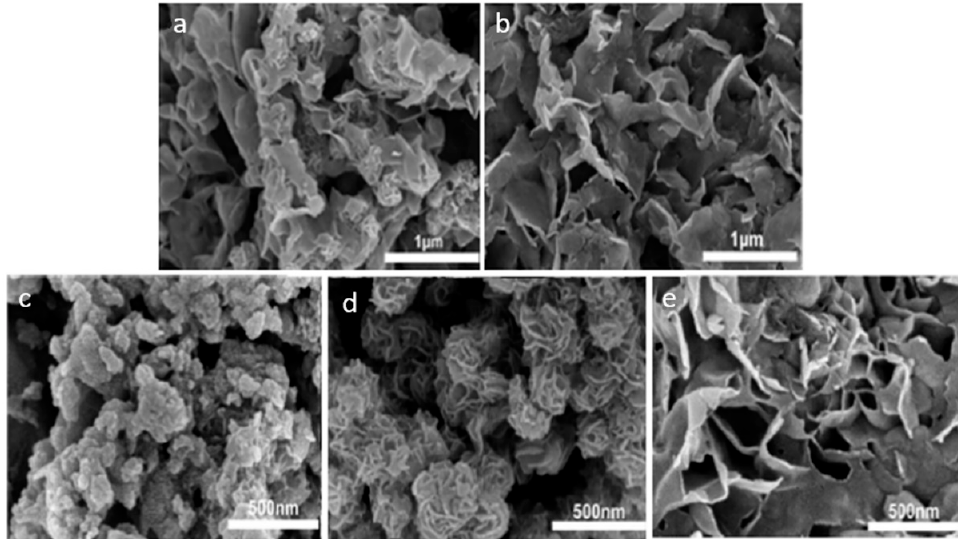
Figure 3. SEM images of MoS 2 composites synthesized via the hydrothermal method. ( a ) S/Mo molar ratio 1:1; ( b ) S/Mo molar ratio 4:1; ( c ) synthesis time: 25 h at 150 °C; ( d ) synthesis time: 37 h at 180 °C; ( e ) synthesis time: 47 h at 240 °C. Reprinted from [83]. Copyright (2019), with permission from Elsevier.